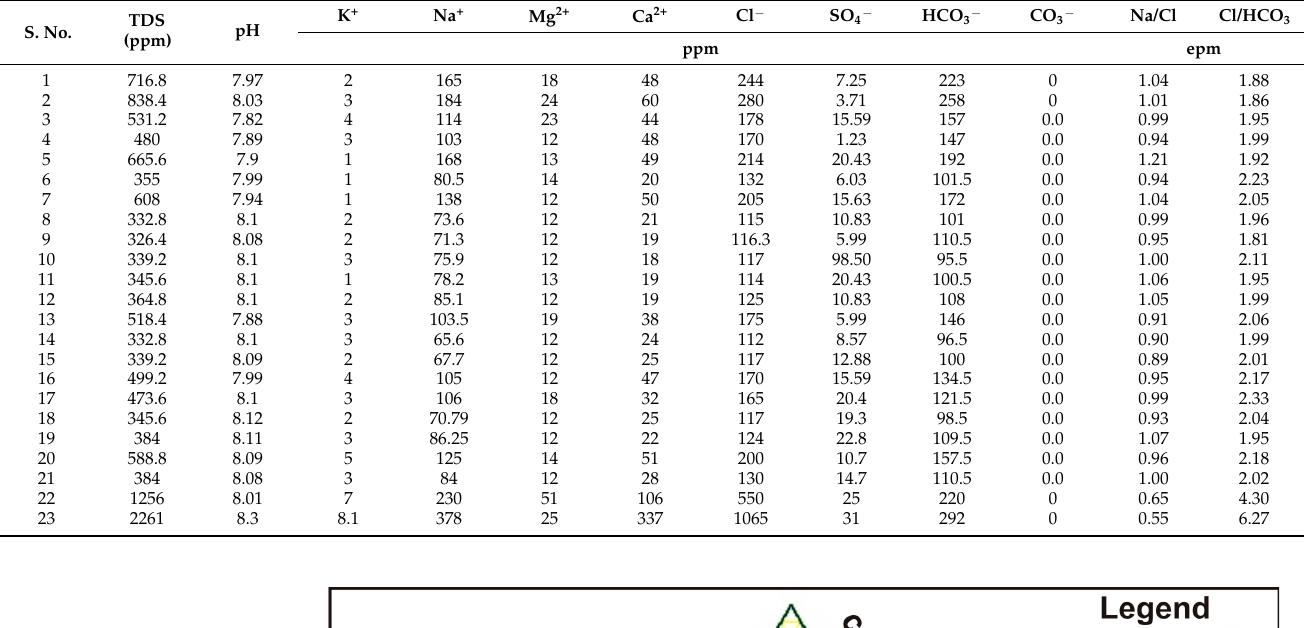
Table 2. Chemical compositions and field data of groundwater samples in the El-Qaa Plain aquifer system.